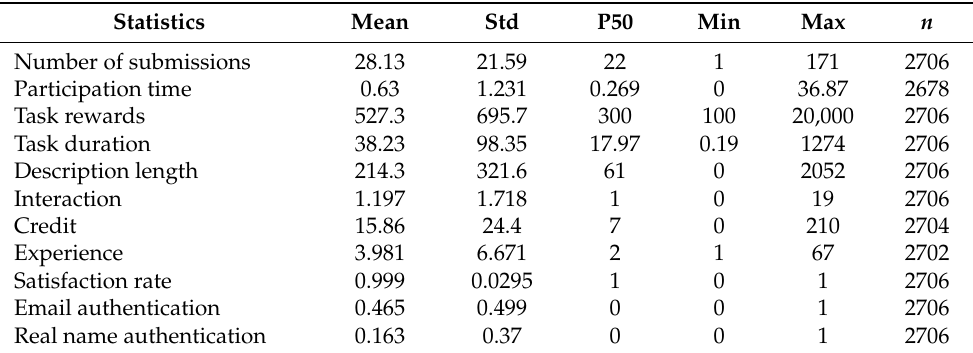
Table 3. Descriptive statistics of the main variables.